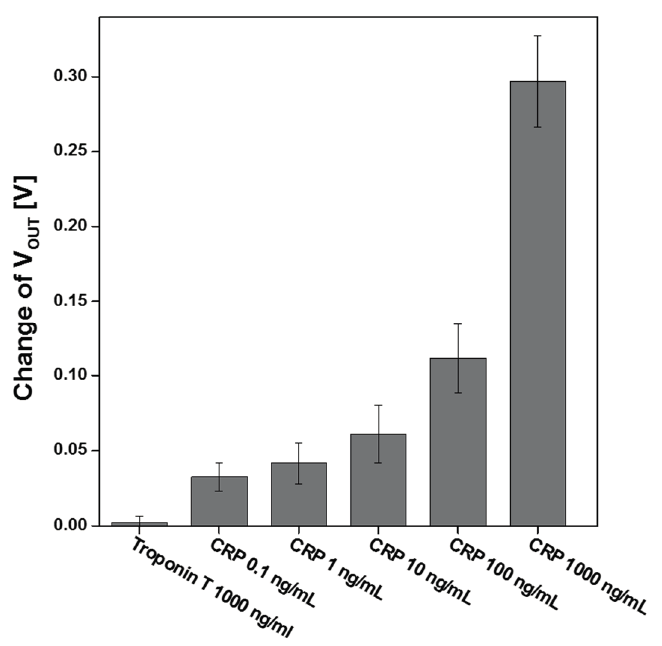
Figure 8. Variation of V OUT with concentration of